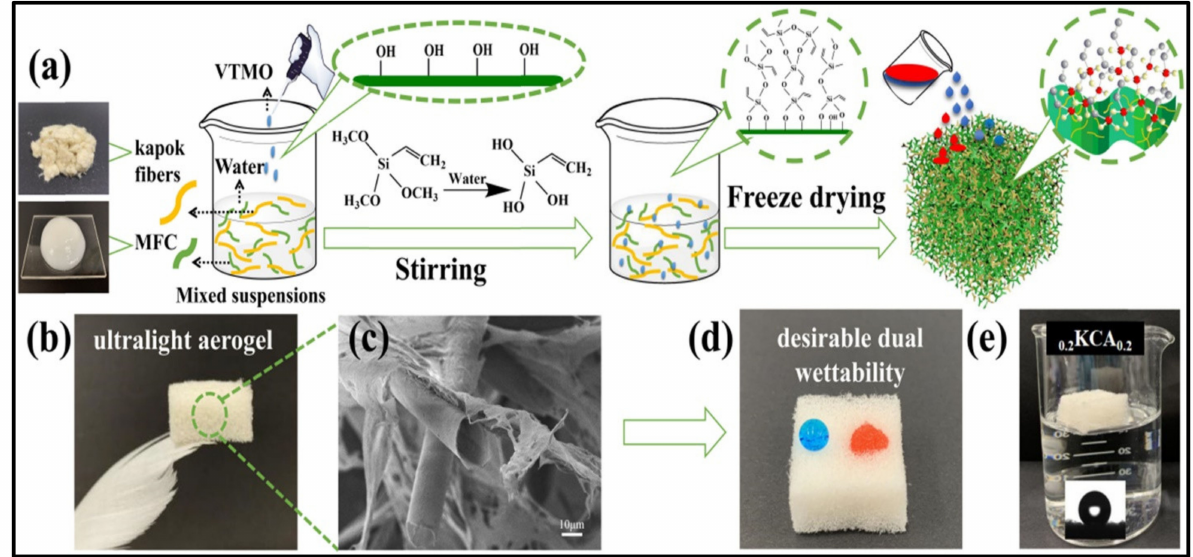
Figure 4. Illustration of hydrophobic cellulose-based aerogel properties: ( a ) schematic drawing of the fabrication approach using freeze-drying; ( b ) realistic image of prepared aerogel; ( c ) SEM image of the aerogel; ( d ) wettability characteristic of the aerogel; ( e ) water contact angle. Adapted from [79], with permission from Elsevier,